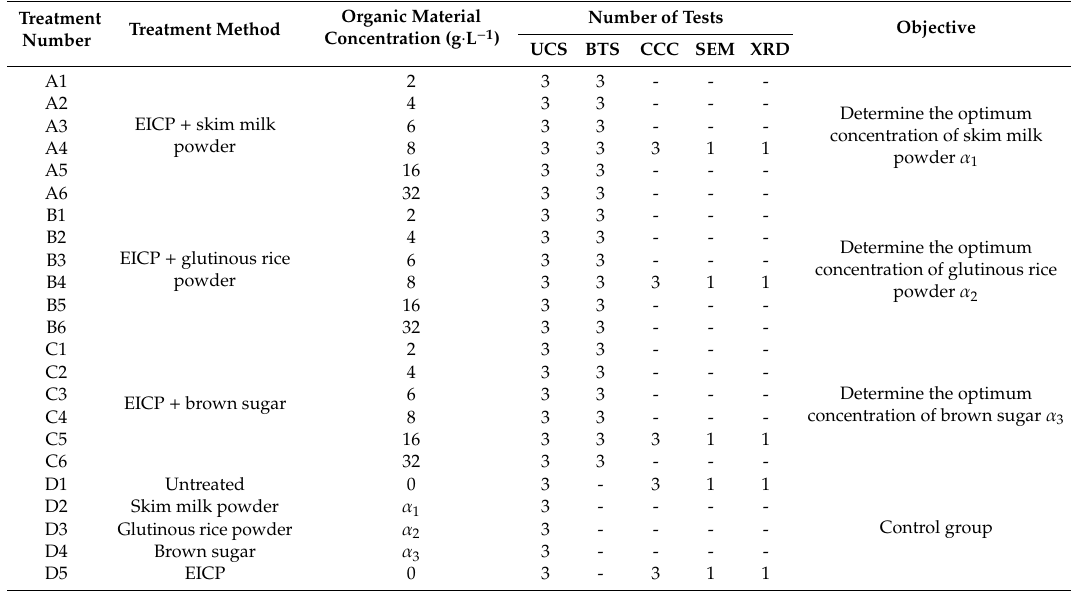
Table 2. Scheme of soil reinforcement